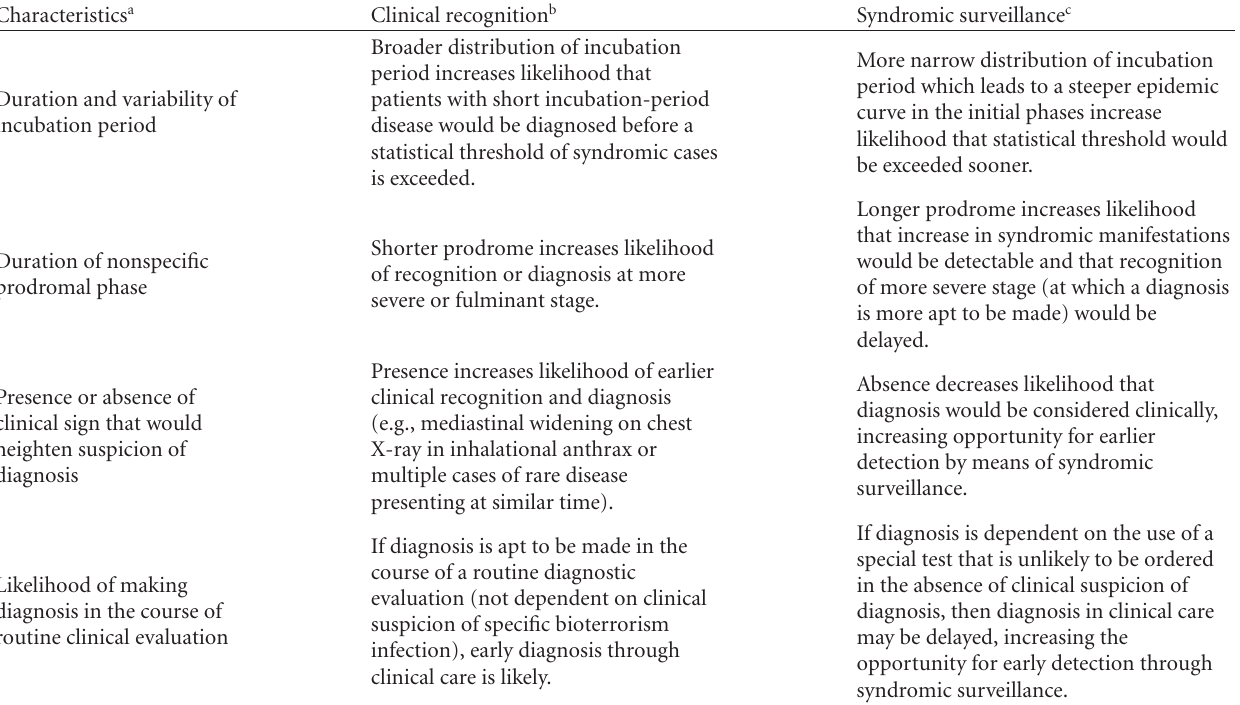
Table 1: Characteristics of bioterrorism-related epidemics that a ff ect detection through clinical recognition versus syndromic